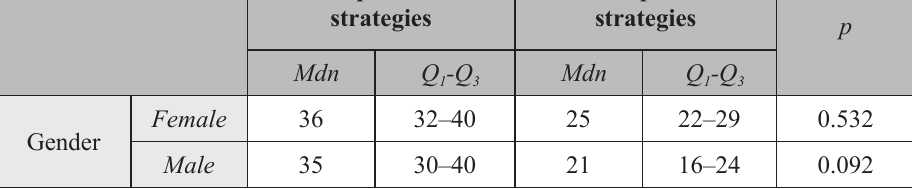
Figure 6. Adaptive and Maladaptive Emotion Regulation Strategies Use Between